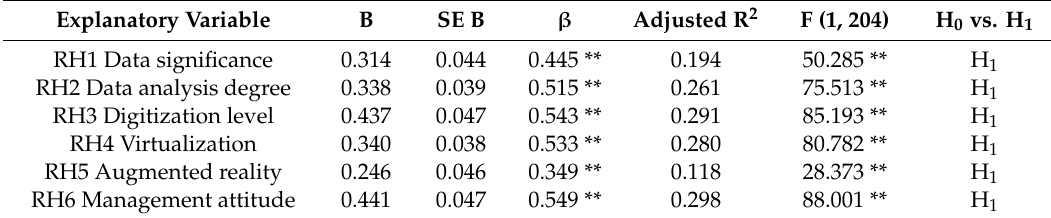
Table 5. Evaluation of the research hypotheses.